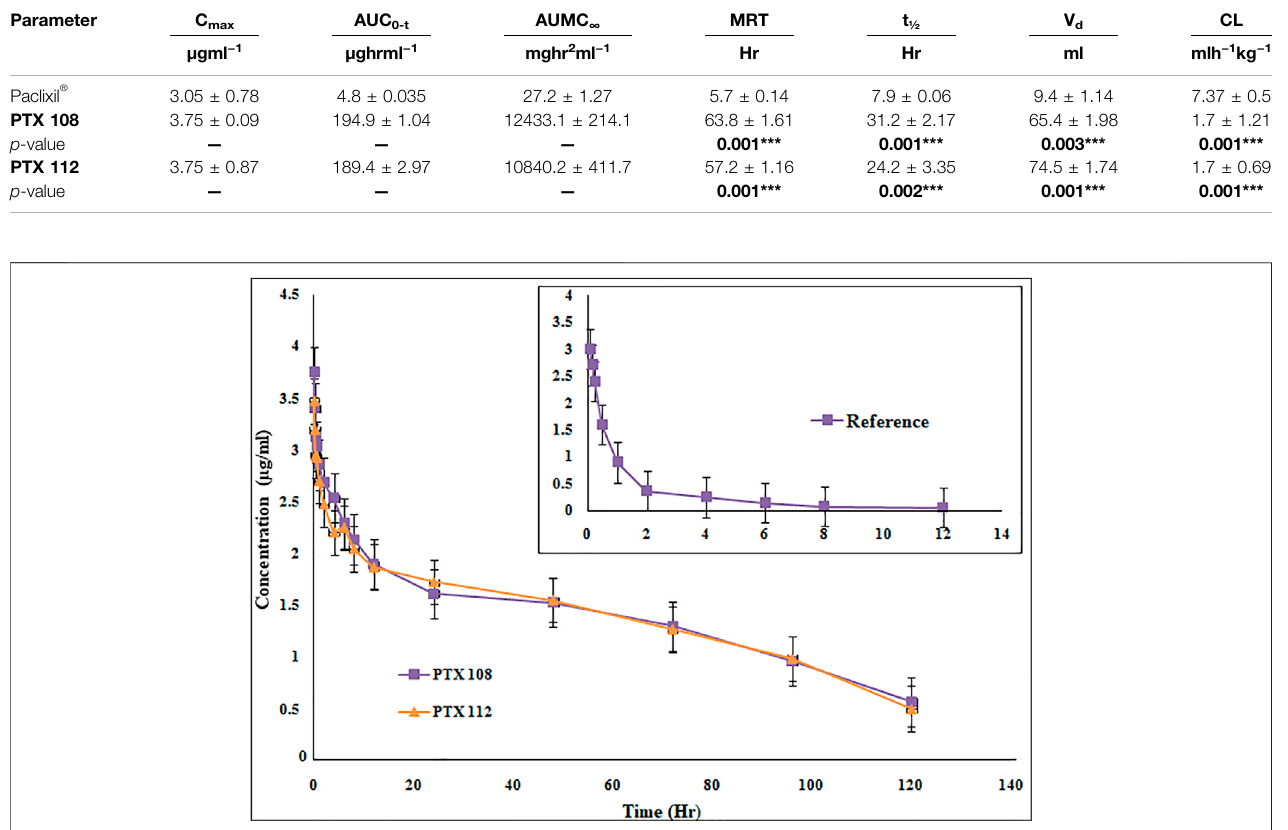
FIGURE 8 | Plasma concentration versus time pro fi le of paclitaxel nanoformulations with poloxamer 407 and SLS.